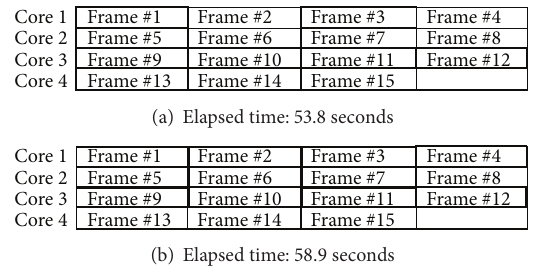
Figure 16: The elapsed time taken in different order of tampered frames organization during parallel watermarking authentication